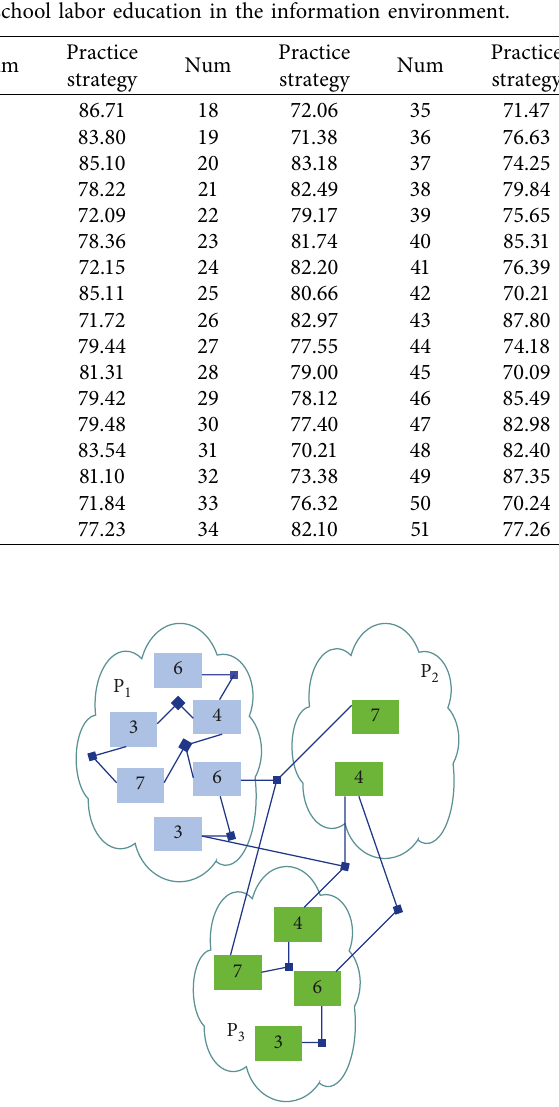
Figure 3: A simple hypergraph partitioning model.